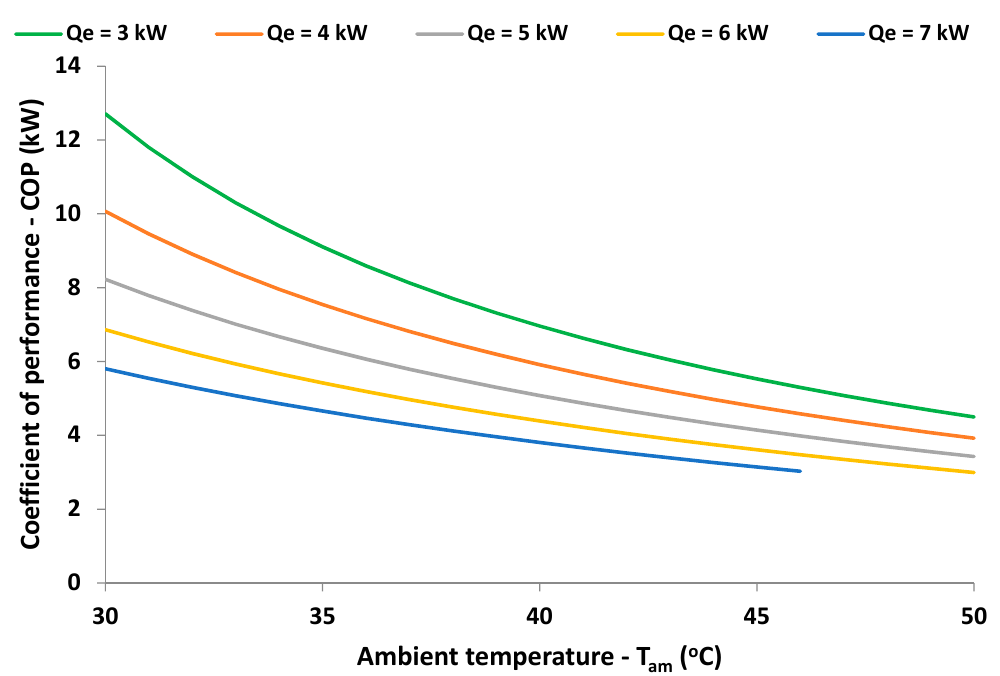
Figure 14. Coefficient of performance for different ambient temperatures and cooling capacities ( T ind = 25 °C and 1000 rpm < n < 4000 rpm). Appl. Sci. 2018 , 8 , x FOR PEER REVIEW